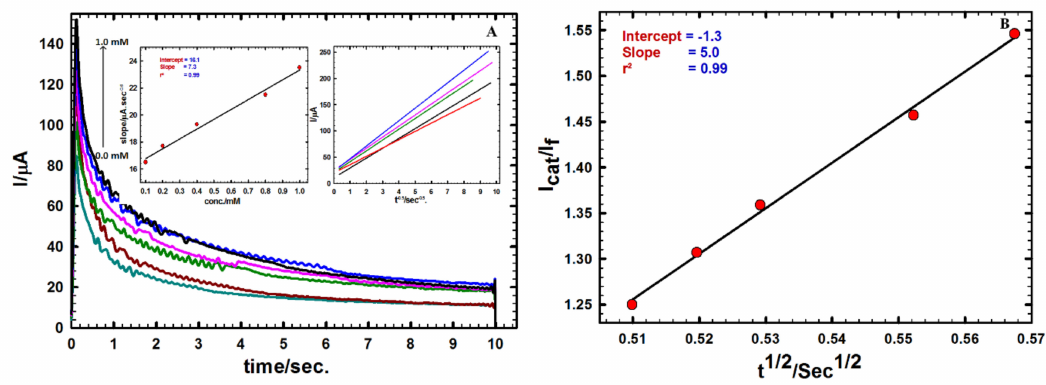
Figure 4. ( A ) Chronoamperograms at GNMSPE for di ff erent concentration of Moxi (0.0–1.0 mM). Insets: Variations of I vs. t − 1 / 2 built from chronoamperograms (right) ant plot of the corresponding slopes against Moxi concentration (left). ( B ) Variation of I cat / I f ratio versus t 1 / 2